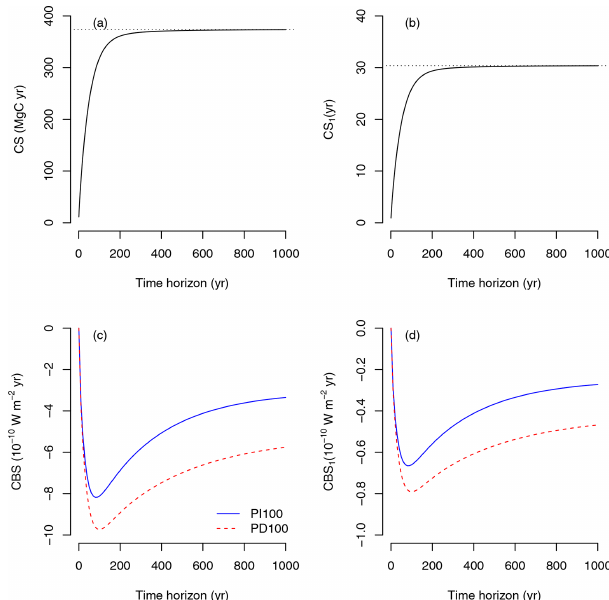
Figure 4. Carbon sequestration (CS) and climate benefit of seques- tration (CBS) for instantaneous carbon uptake at any given time. (a) CS due to the uptake of 12.3MgCha − 1 , which corresponds to GPP of 1 year. (b) CS due to the uptake of one unit of carbon (CS 1 ). (c) CBS due to the uptake of 12.3MgCha − 1 for two different im- pulse response functions (pre-industrial atmosphere with a pulse of 100Gt of carbon: PI100, and present-day atmosphere with a pulse of 100Gt of carbon: PD100). (d) CBS due to the uptake of one unit of carbon (CBS 1 ) for two different impulse response function. Dot- ted lines in (a) and (b) represent steady-state carbon storage and mean transit time, respectively.